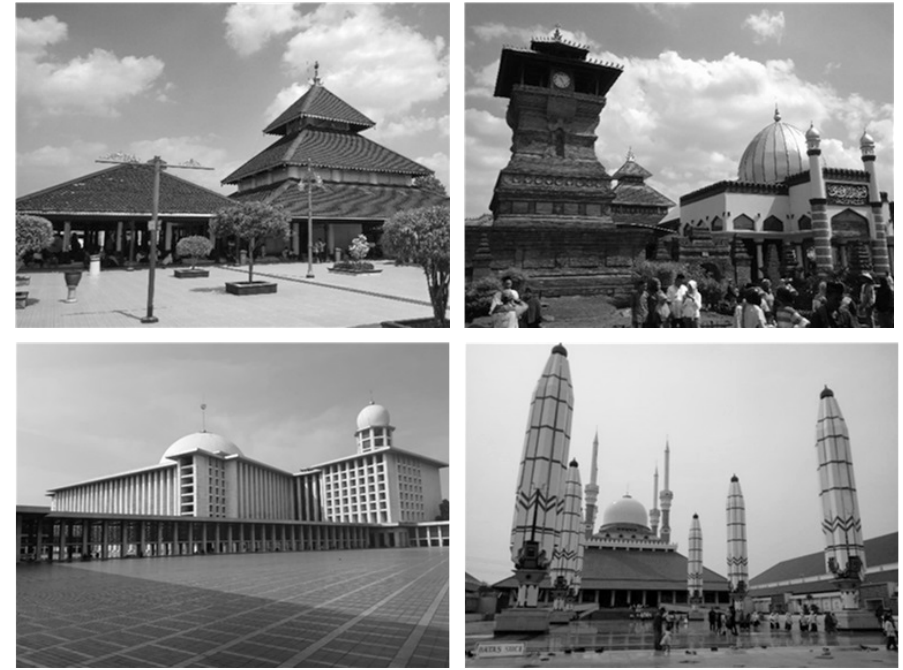
Figure 2. Javanese mosques from the older to newer: Demak (left-top), Kudus (right-top), Jakarta (left-bottom), and Semarang Great mosques (right-bottom) (photos: author)